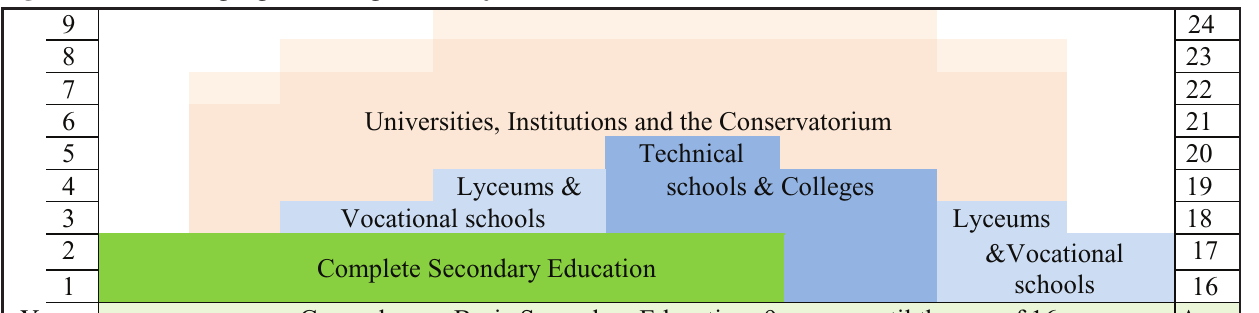
Figure 1 Schooling, age, and degrees in